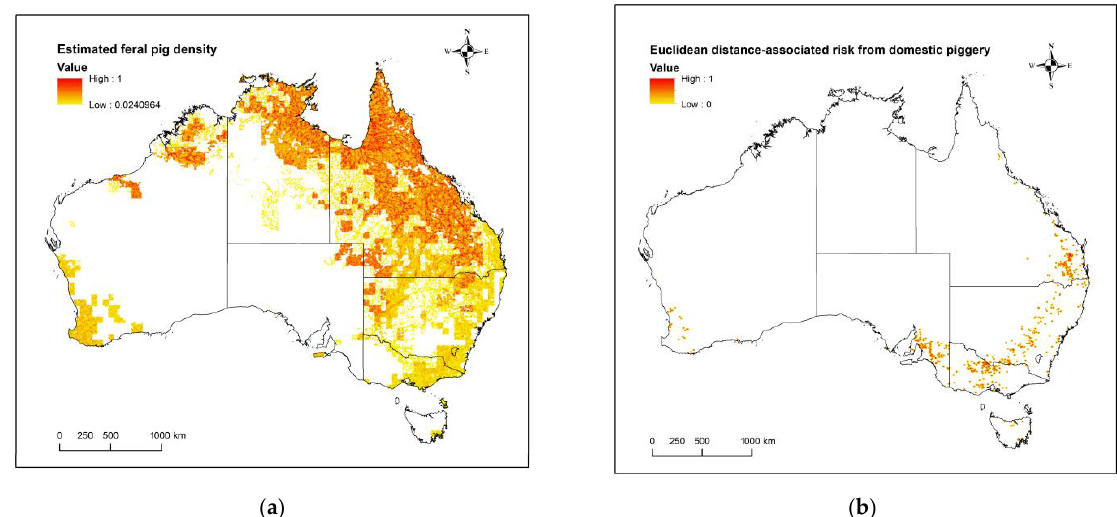
Figure 3. ( a ) represents the relative estimated density of feral pigs in Australia, where the normalized density ranges from 0 (white) and low density (yellow) to 1 (red) (DAFF, 2022). ( b ) represents an exponential relationship for the Euclidean distance from a domestic piggery in Australia, where high risk (red) is the location of a piggery, which exponentially declines as distance increases with values levelling out at 10 km from the piggery denoting low risk (yellow) and beyond that zero risk (white).